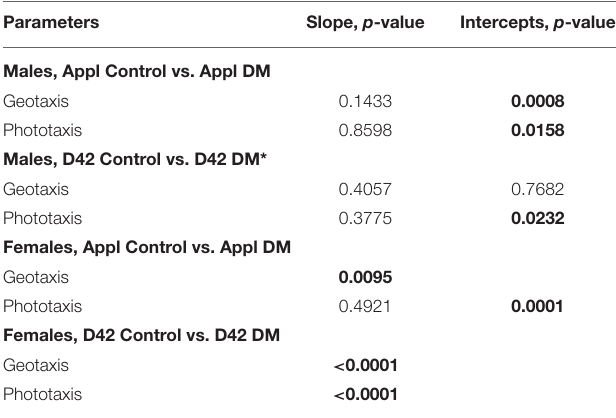
TABLE 3 | Statistical analysis of geo- and phototaxis scaled to percent life span, relied on comparison of the regression curve slopes and intercepts. Parameters Slope, p -value Intercepts, p -value